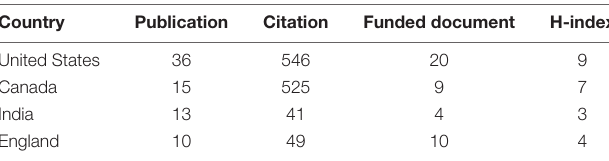
TABLE 1 | Country